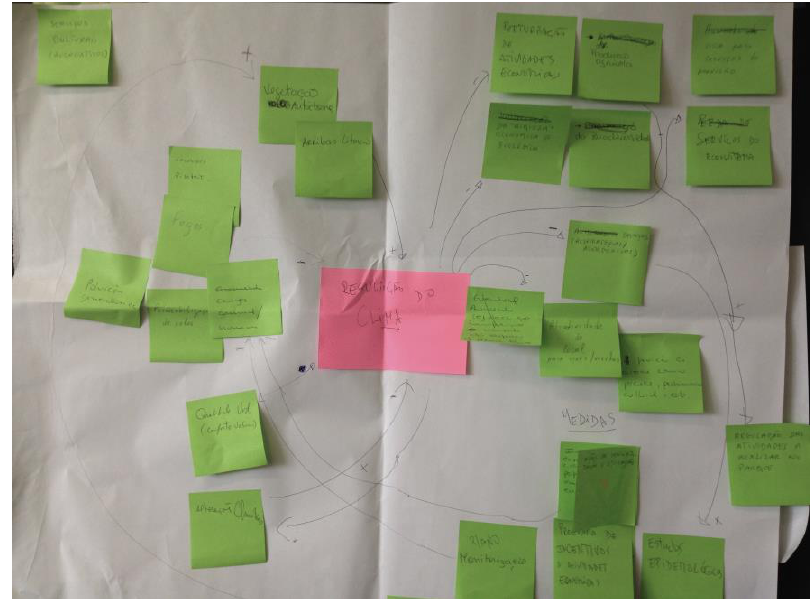
Fig. 3. Picture of the causal loop diagram developed by workshop participants for the climate regulation ecosystem